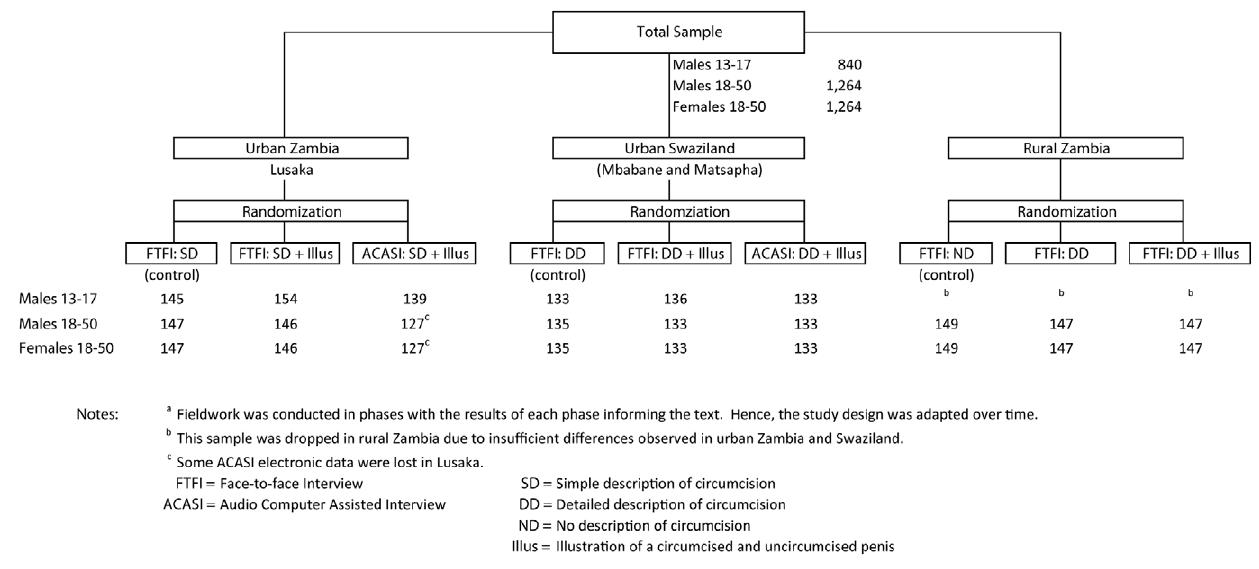
Figure 1. Study design and experimental assignment by setting. doi:10.1371/journal.pone.0036251.g001 21% of adult men were classified as circumcised. Circumcision prevalence is similar in urban Swaziland, but lower for rural Zambia. The prevalence of MC in urban areas of each country is somewhat higher than MC prevalence found by the DHS for each